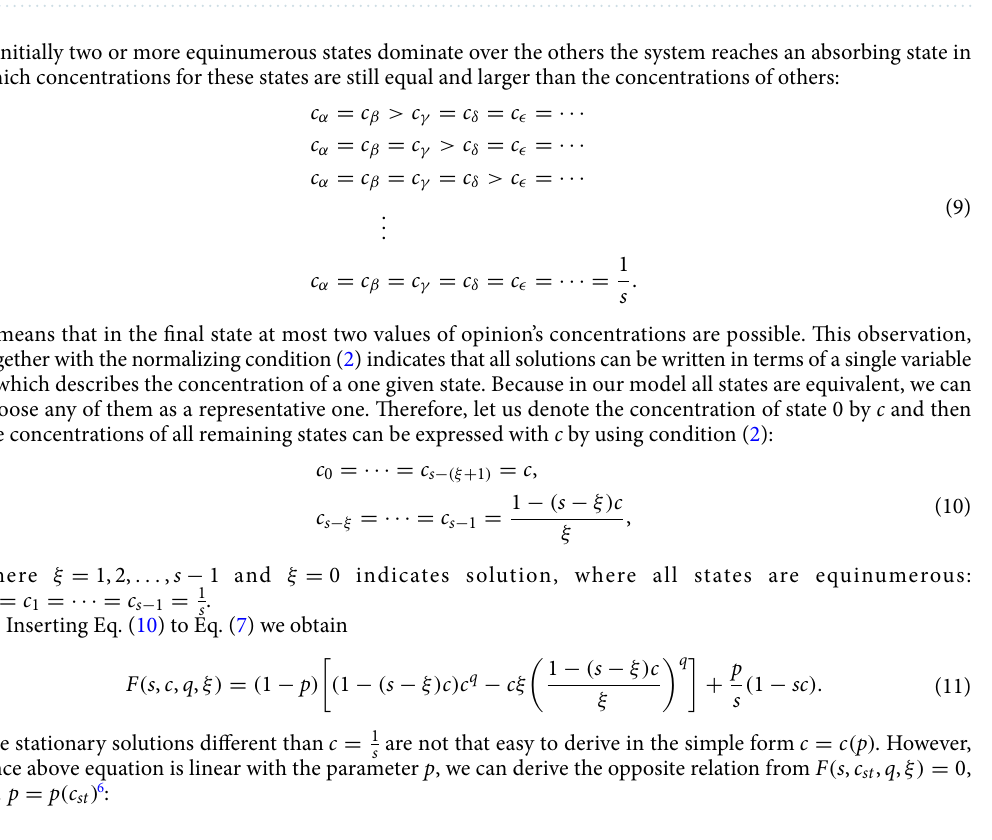
10 . Figure 2. Trajectories for the multi-state annealed q -voter model on the complete graph of size N = 10 5 with the size of the influence group q = 5 and s = 3 states. Upper and lower panels differ by the amount of noise: p = 0.025 at the top row and p = 0.09 at the bottom one. Markers and color areas represent the outcome of Monte Carlo simulations and thick solid black lines are results of analytical prediction obtained from Eq. (7). Symbols represent median trajectory over 50 samples. The shaded color areas show the range of trajectories, i.e. are limited by 0 and 100th quantiles. Note that Monte Carlo simulations show a good agreement with analytical solutions in all panels, except of the third one in the upper row. The reason for this inconsistency is that in this case we are dealing with the hyperbolic (saddle) fixed point, i.e., a stable, as well as an unstable manifold exist 41 . Therefore, within MC simulations the system always eventually leaves such a state due to the finite-size